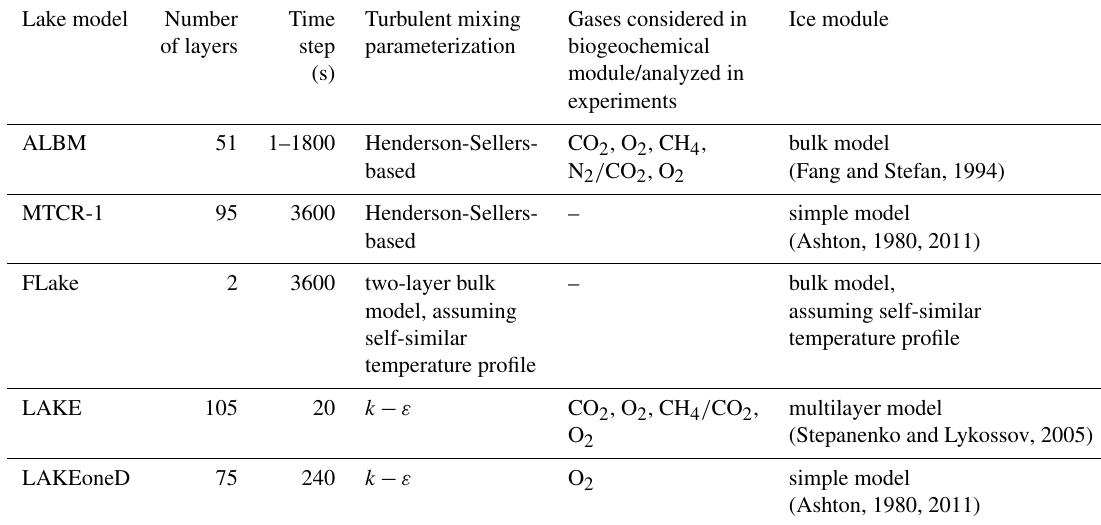
Table 2. Characteristics of lake models relevant to the study. Lake